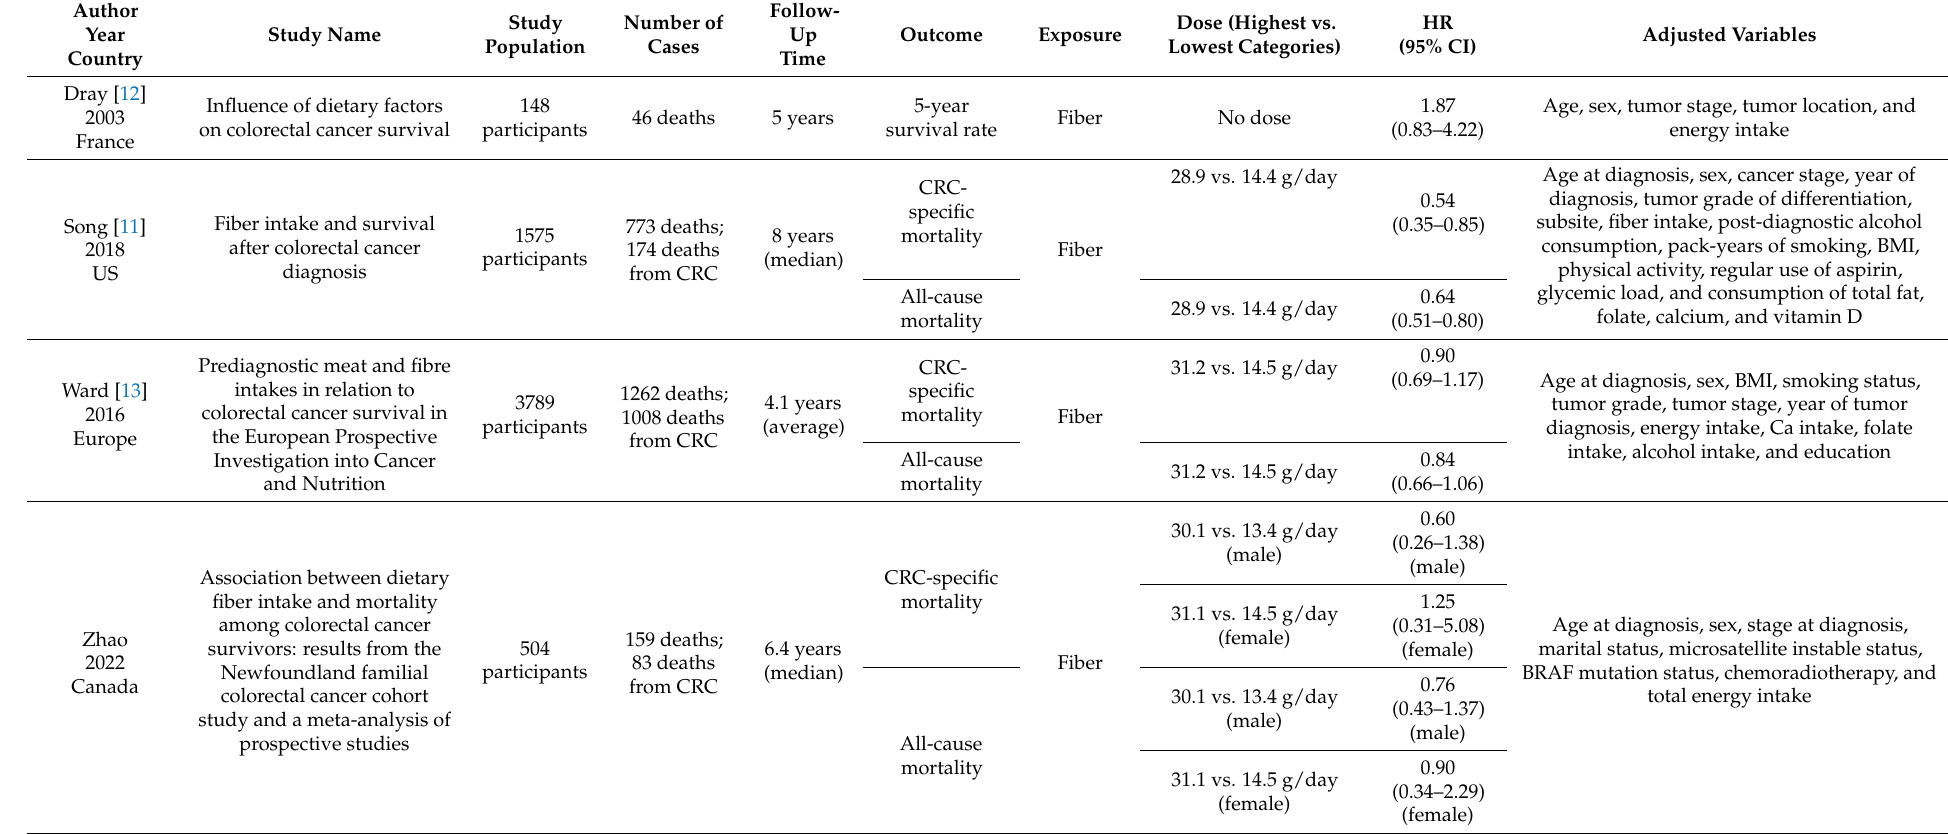
Table 3. Characteristics of prospective cohort studies included in the meta-analysis of dietary fiber intake and outcome of